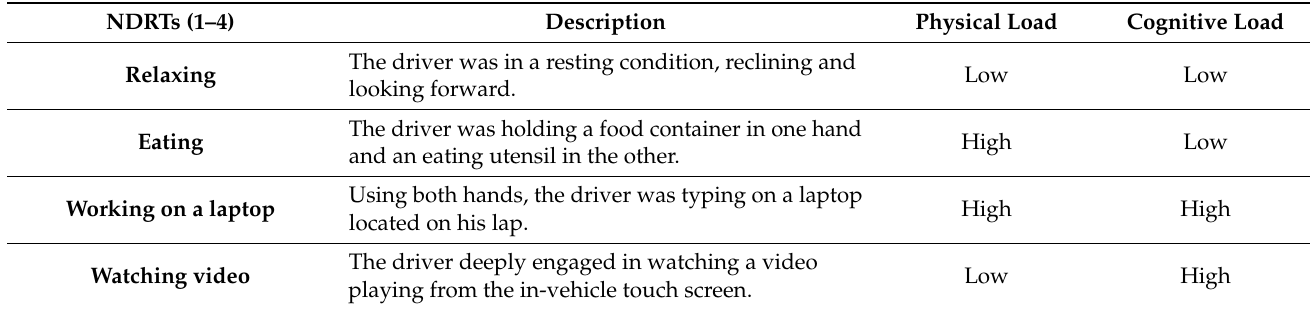
Table 1. Description of Non-driving Related Tasks (NDRTs) and condition distribution for physical and cognitive load. NDRTs (1–4)